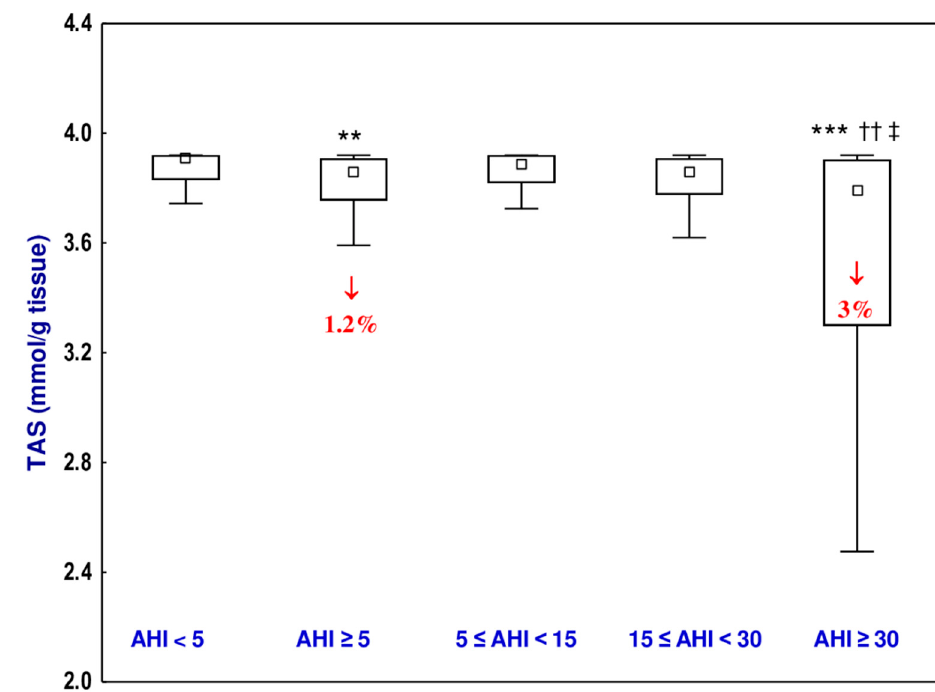
Figure 3. Total antioxidative status (TAS) of the uvular mucosa of the participants with obstructive sleep apnea syndrome (OSAS) and in non-OSAS participants. Data represent median, 25–75% confidence interval, as well as minimum and maximum. ** p < 0.01, *** p < 0.001 compared to apnea–hypopnea index (AHI) < 5; †† p < 0.01 compared to 5 ≤ AHI ˂ 15; ‡ p < 0.05 compared to 15 ≤ AHI ˂ 30. ↓ —decrease compared to AHI < 5.